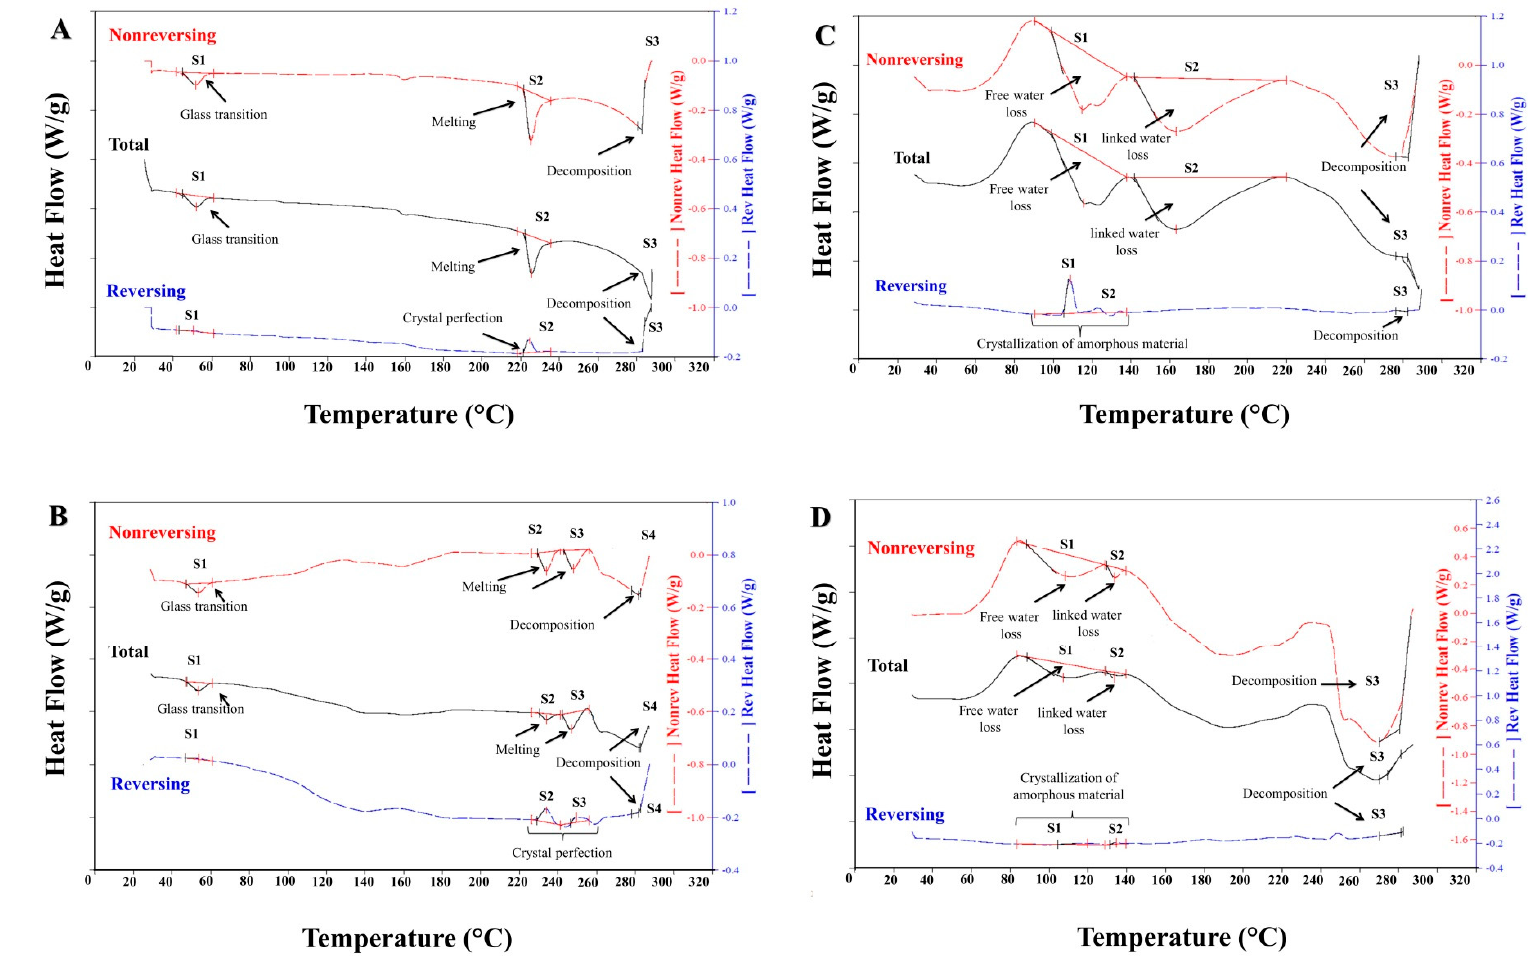
Figure 5. Modulated differential scanning calorimeter (DSC) of ( A ) Eudragit ® E 100; ( B ) Eudragit ® E PO, ( C ) EuCl-E-100 and ( D ) EuCl-E-PO.